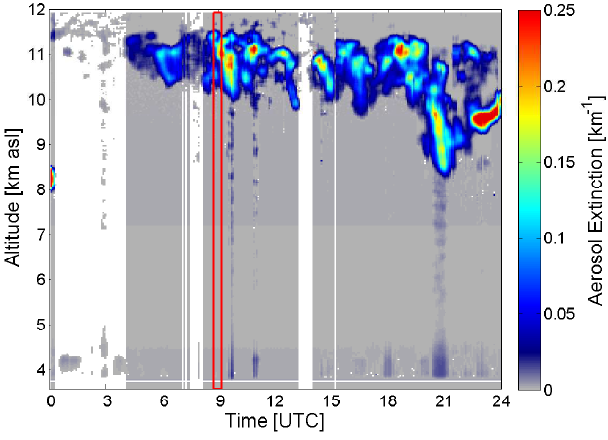
Figure 1. Lidar measurement at Jungfraujoch on 22 Novem- ber 2011. Colours: aerosol extinctions retrieved from measured